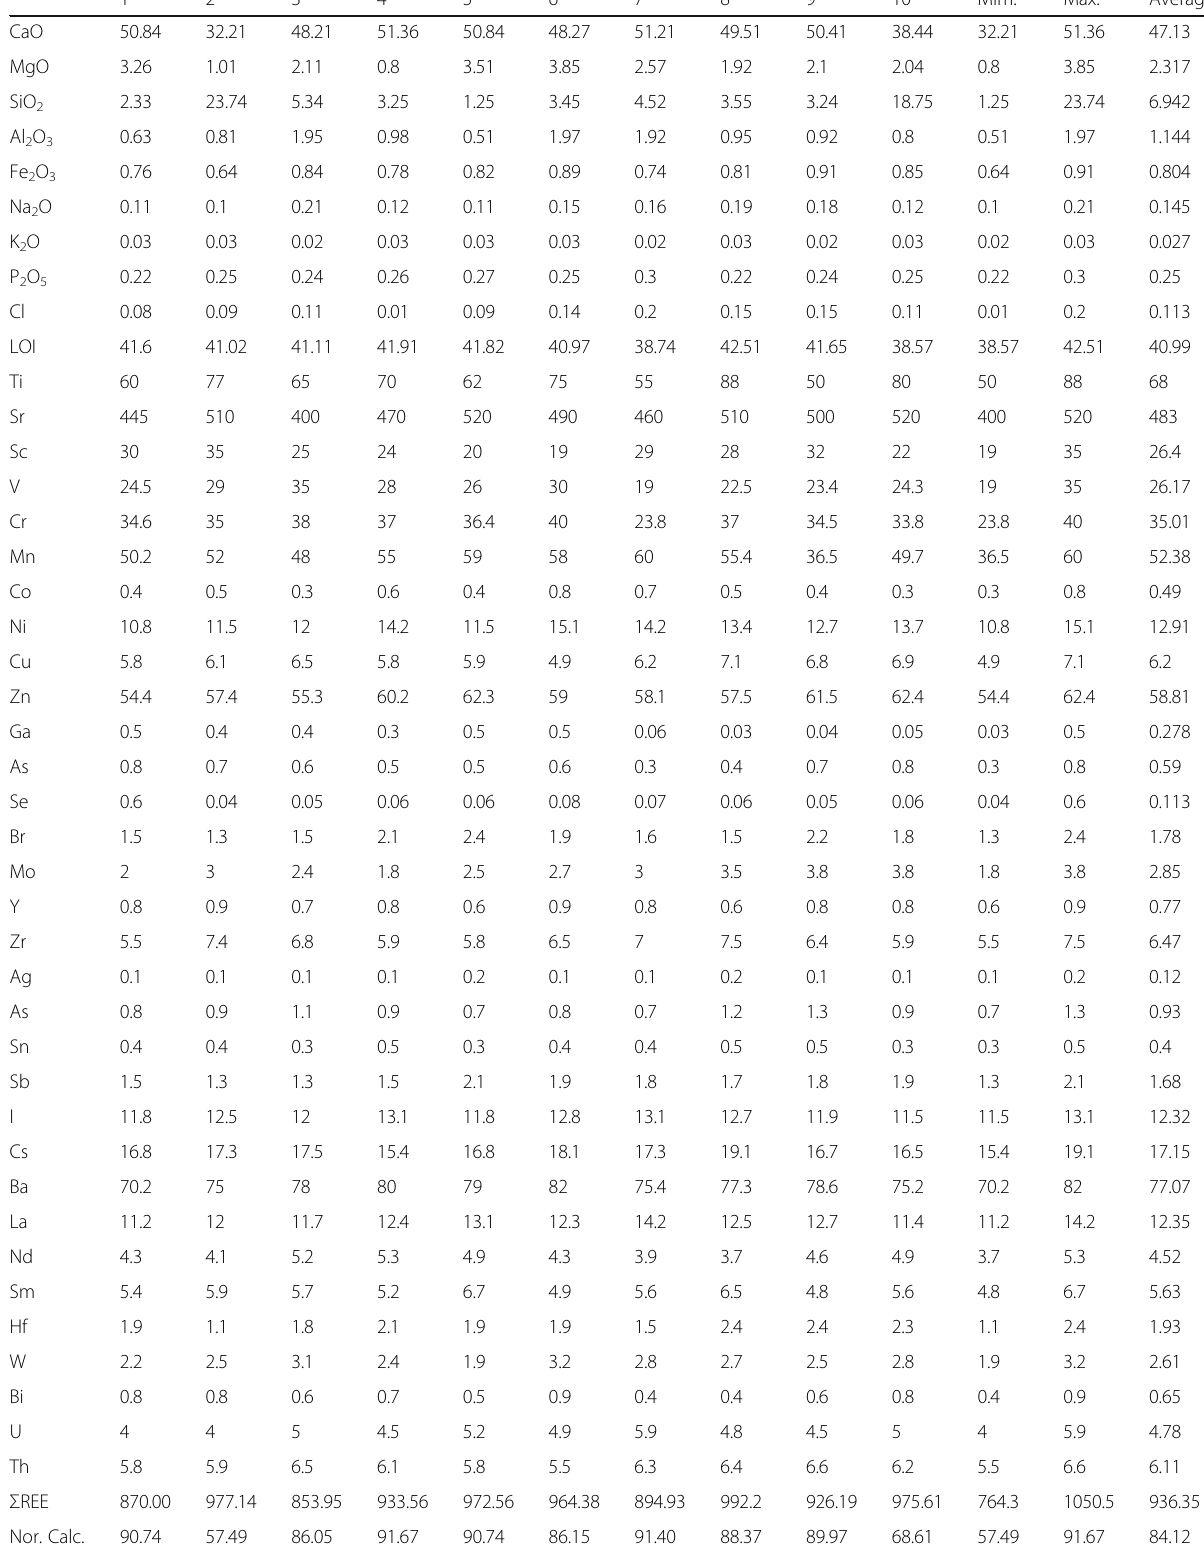
Table 1 Chemical analysis data of major oxides (%) and trace rare earth elements (ppm), of the studied